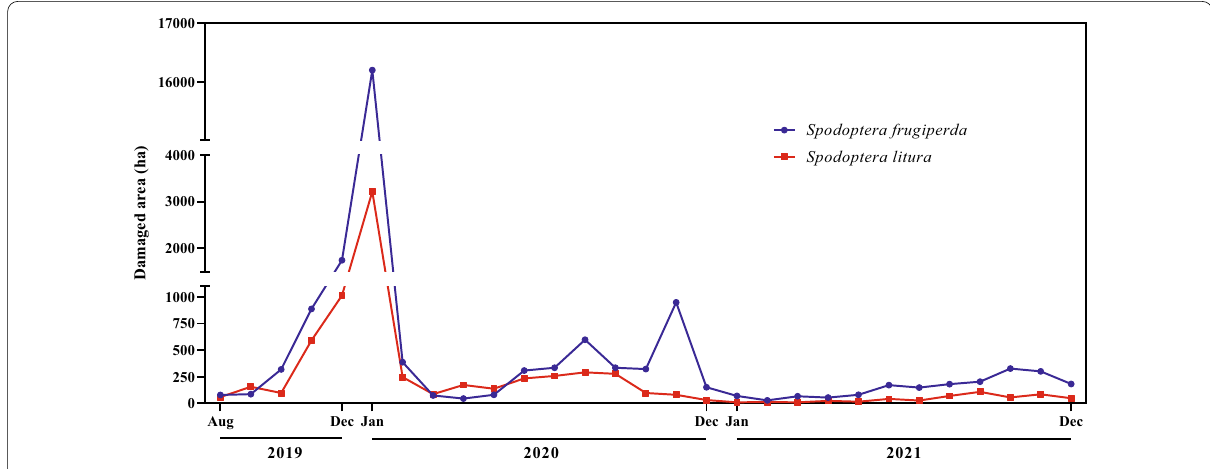
Fig. 1 The damaged area of maize fields caused by Spodoptera frugiperda and Spodoptera litura from August 2019 to December